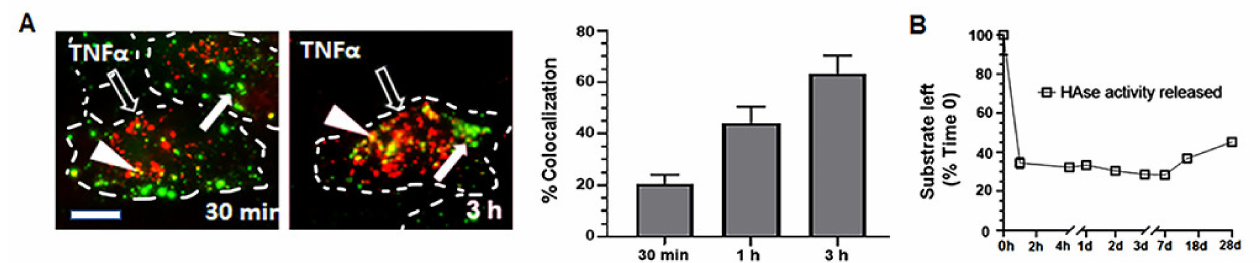
Figure 4. Lysosomal trafficking and released activity of PLGA NPs encapsulating HAse. ( A ) Fluores- cence microcopy pictures (left) and quantification (right) of TNF α -activated HUVECs incubated for the indicated time points with Lactel II–F68 PLGA NPs coated with anti-ICAM and encapsulating AlexaFluor488-HAse (green; white arrows). Cell lysosomes had been labeled with TexasRed dextran (red; open arrows) prior to NP incubation, so that colocalization of HAse with dextran-labeled lysosomes would appear as green + red = yellow color (white arrowheads). Dashed lines = cell borders. Scale bar = 10 µ m. ( B ) Quantification of HA-degrading HAse activity released from NPs upon in vitro incubation for the indicated time points under conditions mimicking the lysosomal environment (lysosomal-simulating fluid, 37 ◦ C and pH 4.5). Enzyme activity was measured as in Figure 1. Data are the mean ±